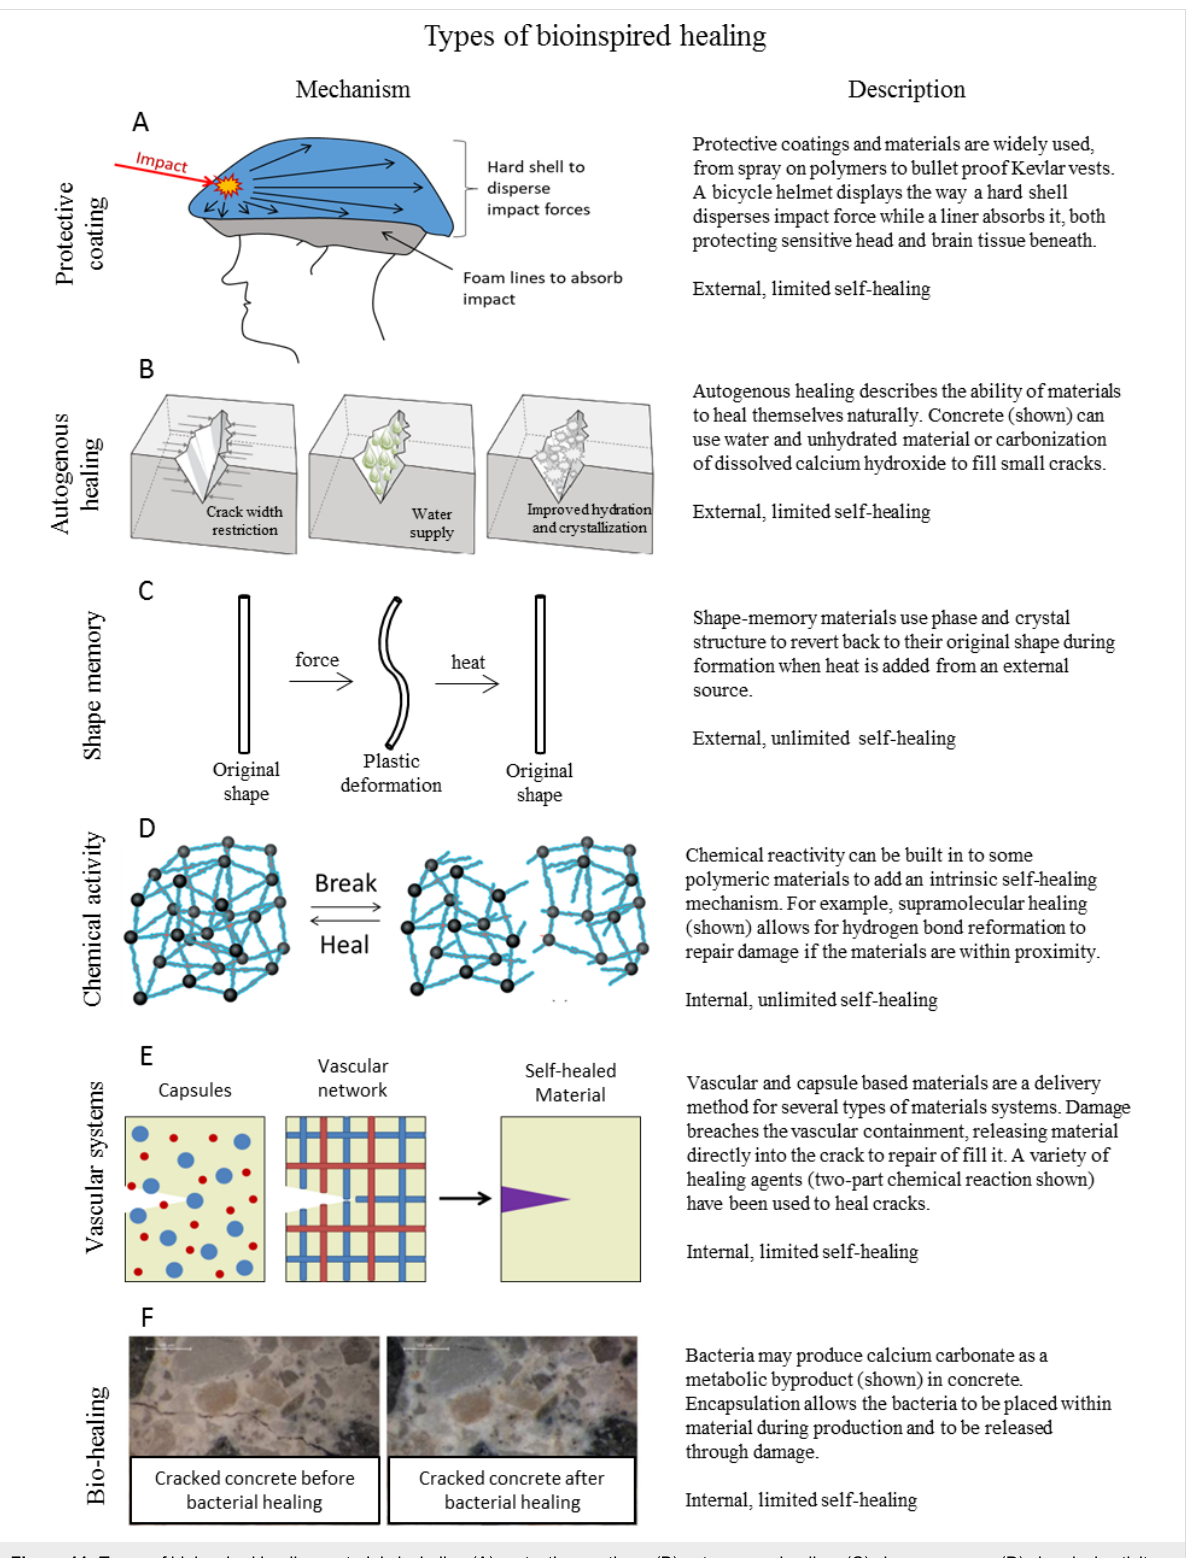
Figure 11: Types of bioinspired healing materials including (A) protective coatings, (B) autogenous healing, (C) shape memory, (D) chemical activity, (E) vascular systems, and (F) bio-healing. Each example is given with a description of the mechanism and comments labeling the (internal or external) source of healing materials/energy and the (limited or unlimited) nature of healing responses. The image in (B) was adapted from [79]. The image in (D) was adapted from [80], copyright 2013 RSC Publishing. The image in (F) was adapted from